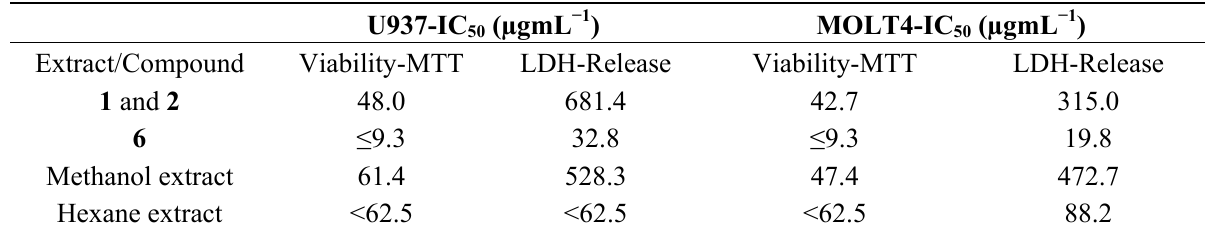
Table 2. IC determination for cellular viability and LDH 50